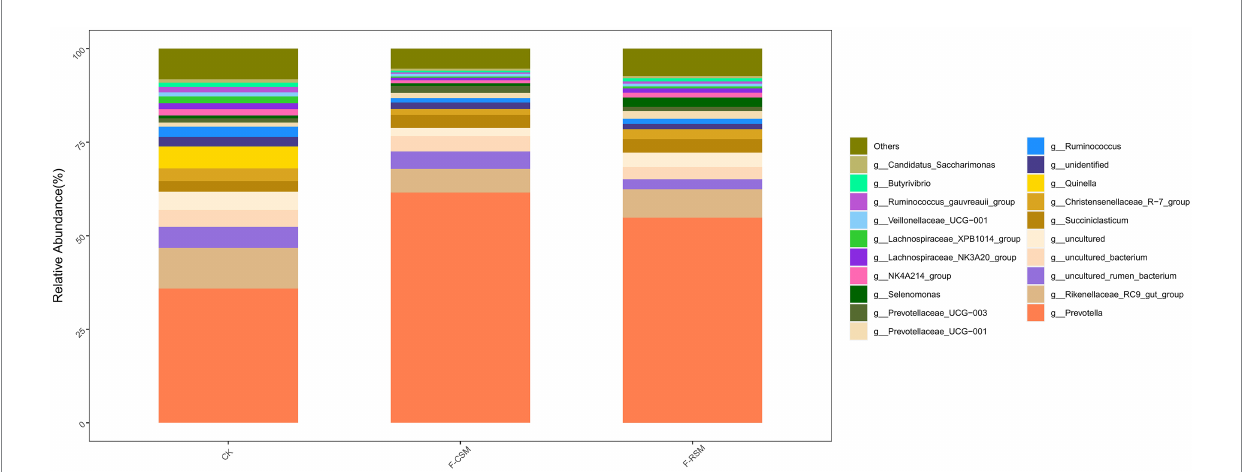
FIGURE 4 Effects of the diets on compositional profifiles of rumen microbiota of Hu sheep (Genus level; %); CK, non-fermented group; F-CSM, fermented Cotton seed meal TMR; F-RSM, fermented Rapeseed meal TMR.